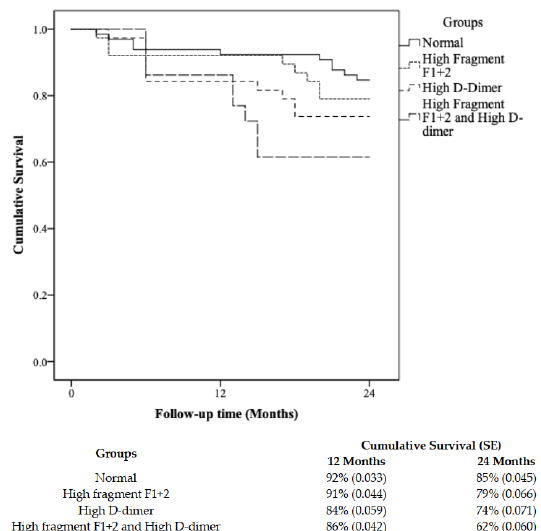
Figure 1. Kaplan – Meier analysis for ABI change ≥ −0 .15 in patients with peripheral artery disease (PAD) stratified into four subgroups based on the F1+2 and D-dimer median values. Subgroup clas- sification: normal ( n = 6 5, F1+2 ≤ 3 .25 nmol/mL and D- Dimer ≤ 1 . 20 μg/mL); high fragment F1+2 ( n = 38, F1+2 > 3.25 nmol/mL and D-d imer ≤ 1 . 20 μg/mL); high D-dimer ( n = 3 8, F1+2 ≤ 3 .25 nmol/mL and D-dimer > 1. 20 μg/mL); high fragment F1+2 and D-dimer ( n = 65, F1+2 > 3.25 nmol/mL and D- dimer > 1. 20 μg/mL).